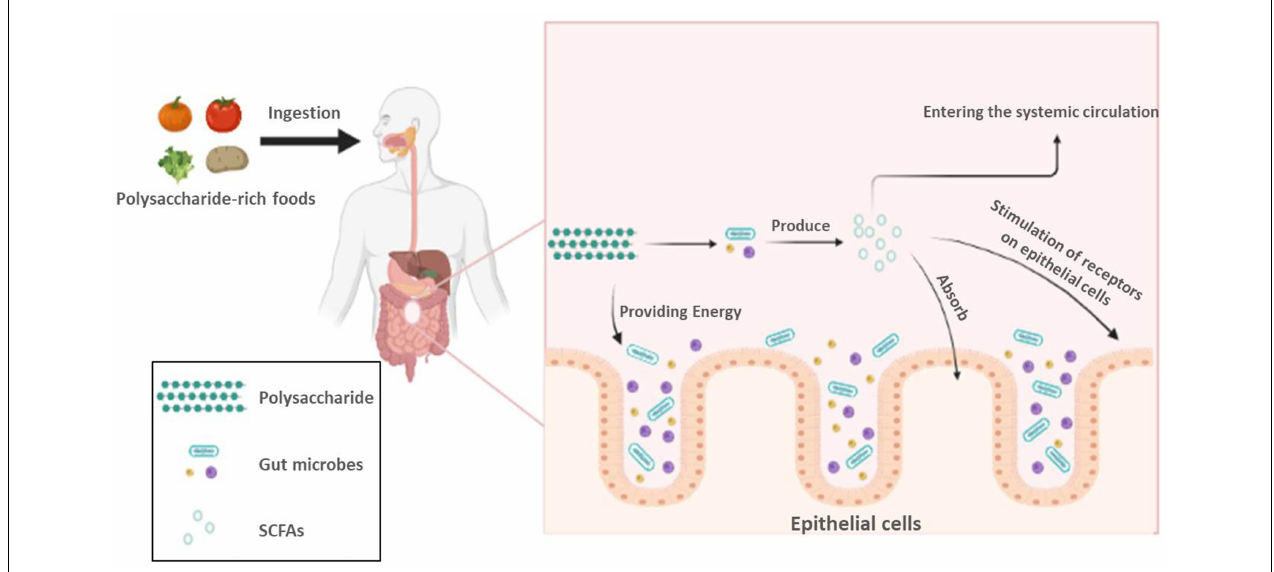
FIGURE 1 | Utilization of polysaccharides by intestinal microorganisms.